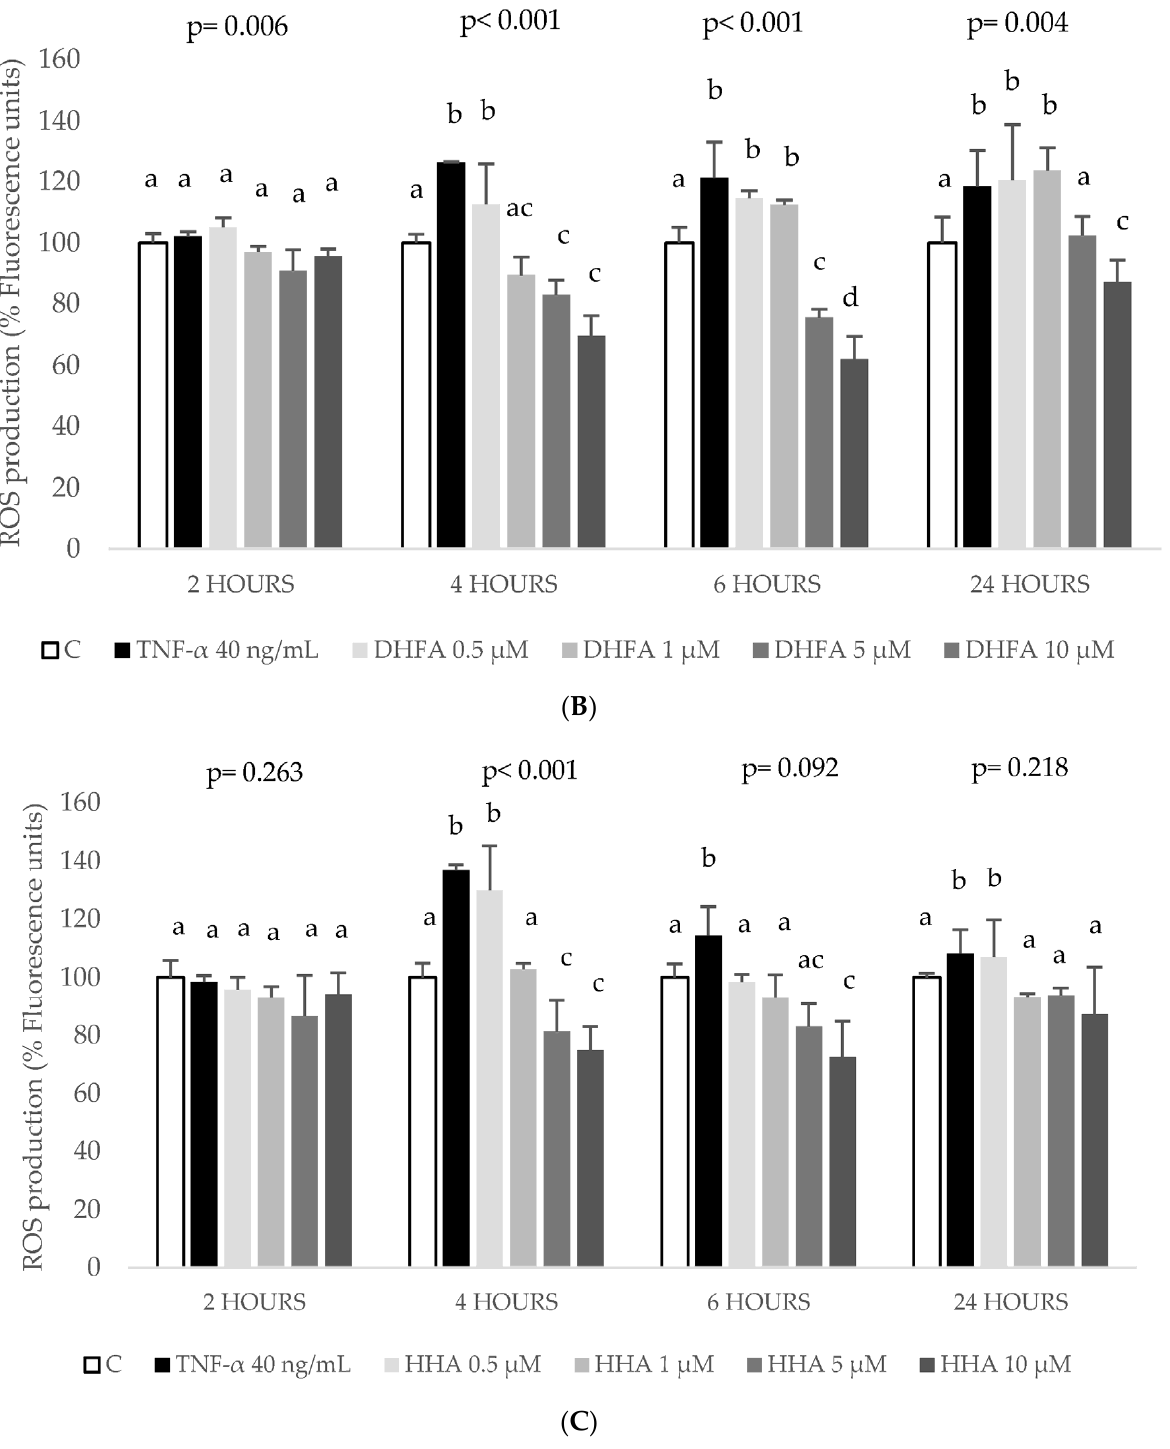
Figure 6. Effect of coffee microbial metabolites dihydrocaffeic acid (DHCA, ( A )), dihydroferulic acid (DHFA, ( B )), and hydroxyhippuric acid (HHA, ( C )) at 0 (control, C), 0.5, 1, 5 and 10 µM on reactive oxygen species (ROS) over-production induced by tumor necrosis factor- α (TNF- α ). HepG2 cells were co-treated with noted concentrations of metabolites and TNF- α (40 ng/mL during 6 h). ROS concentration was determined at the referred time points. Data are means ± SD of 4 different samples per condition. The p values above the figures represent ANOVA results and the different letters denote statistical differences according to the Bonferroni test within the same time point ( p < 0.05). The results indicate that co-treatment with coffee metabolites dose-dependently pre- vent the increased generation of ROS induced by TNF- α . Since the more reliable data was obtained at 6 h of co-treatment, this time point was selected for the rest of the oxidative stress markers.